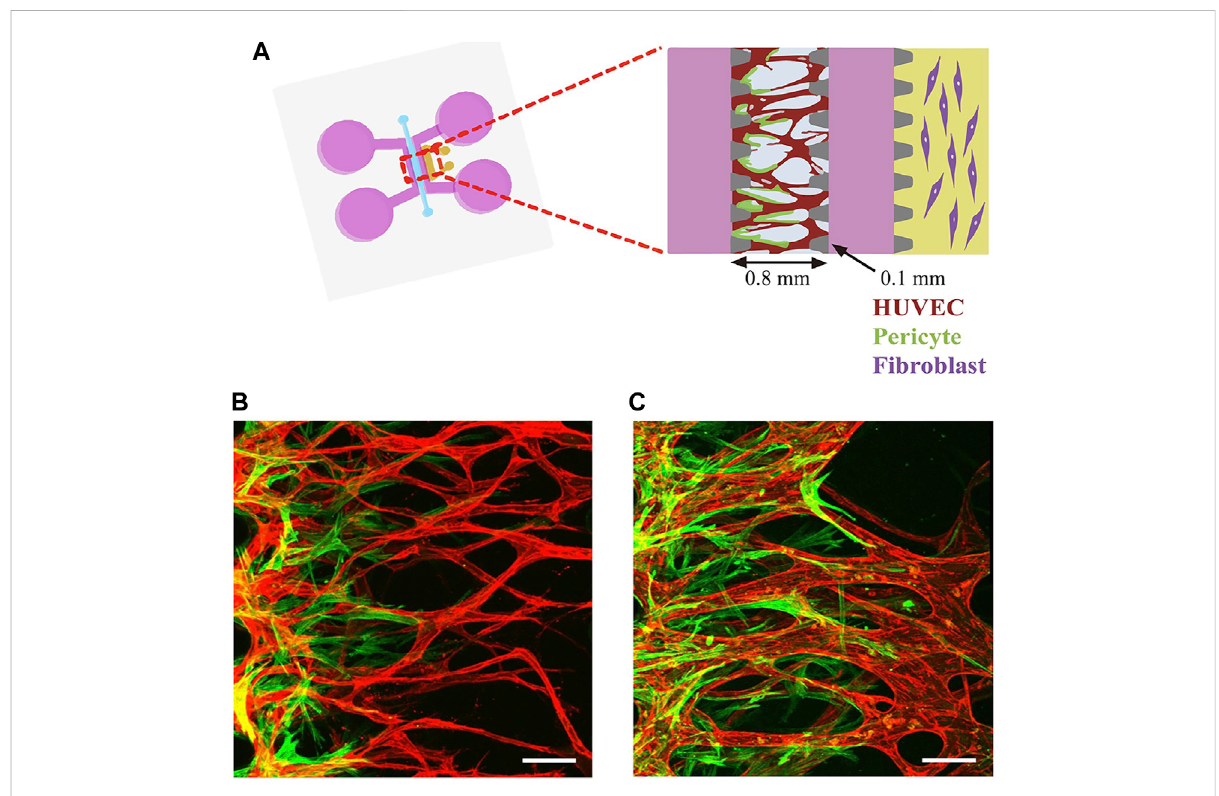
FIGURE 2 Vascularization in micro fl uidic devices. (A) Schematic diagram of the micro fl uidic device composed of two adjacent media channels and the outermost fi broblast channel. (B) third dayof vascularization. (C) matured pericytes covered the perfusable EC networkon day 6, Adapted